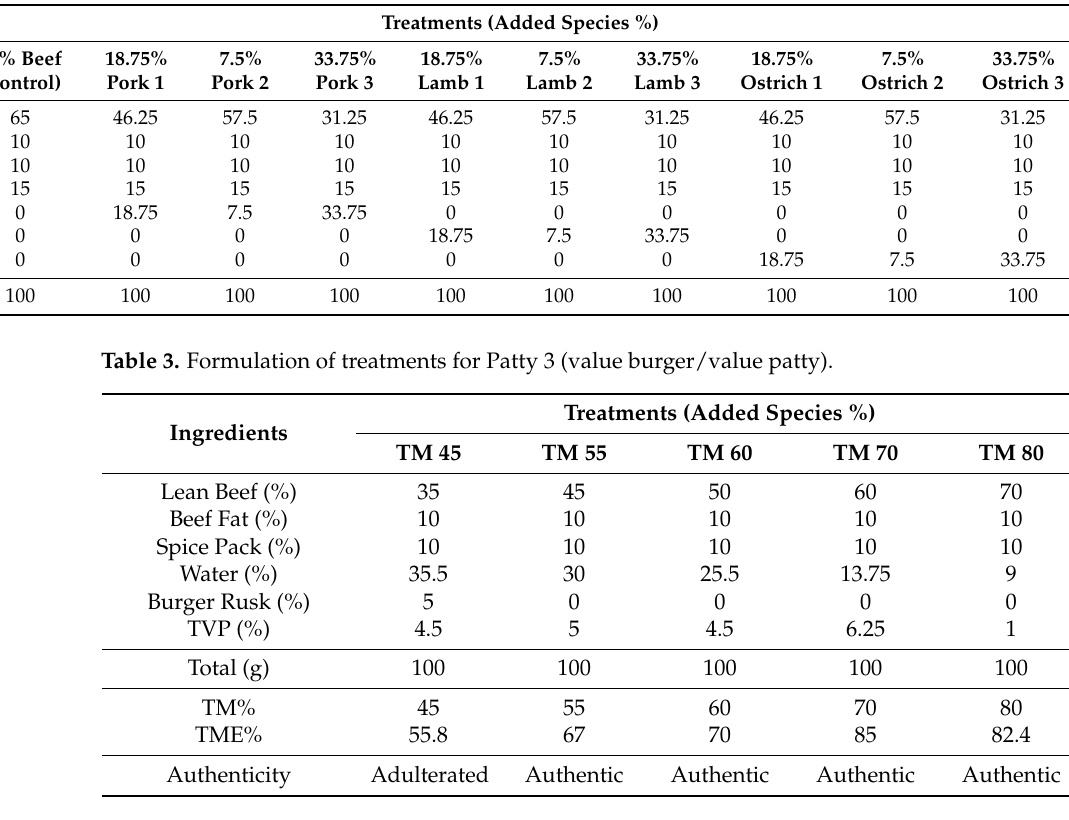
Table 2. Formulation of treatments for Patty 2 (burger/patty/hamburger patty).